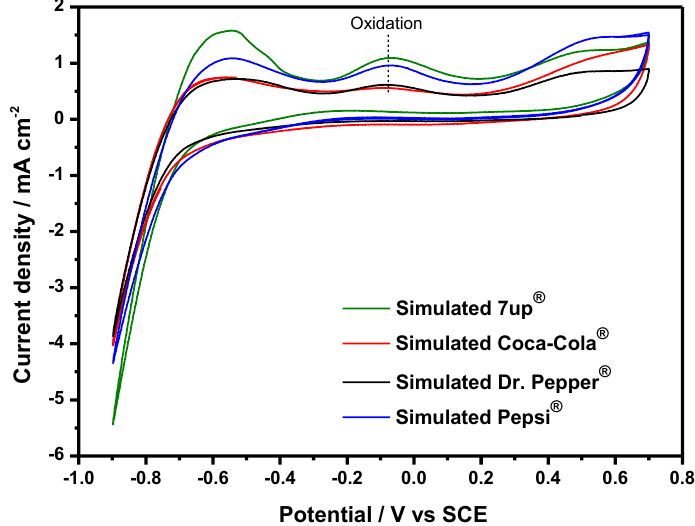
Figure 4. Cyclic voltammograms of PtRu/C on glassy carbon electrode in presence of simulated 7up R (cid:13) , (cid:13) (cid:13) (cid:13) Coca Cola R , Dr. Pepper R , and Pepsi R at a scan rate of 20 mVs − 1 at room